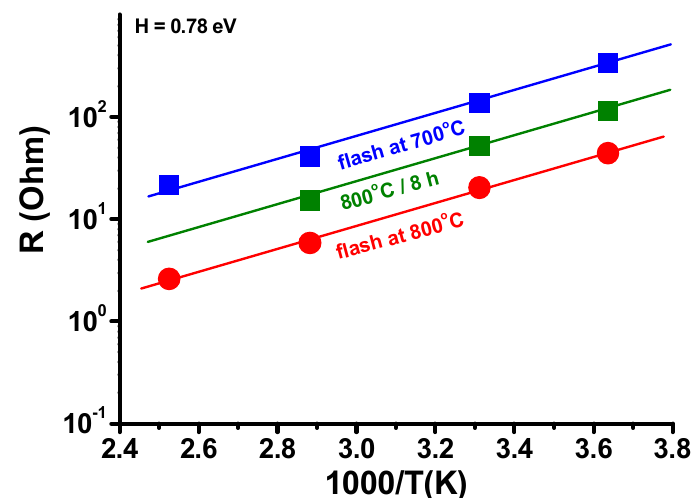
8 Figure 5. Impedance spectroscopy diagrams ( left ) and Bode diagrams ( right ), with data collected at 275 °C, 300 °C, 350 °C, and 400 °C, of BITIVOX samples flash sintered at 700 °C/5 min and at 800 °C/5 min. Bulk resistivity values are shown in the left figures. Maximum frequencies in the right figures.